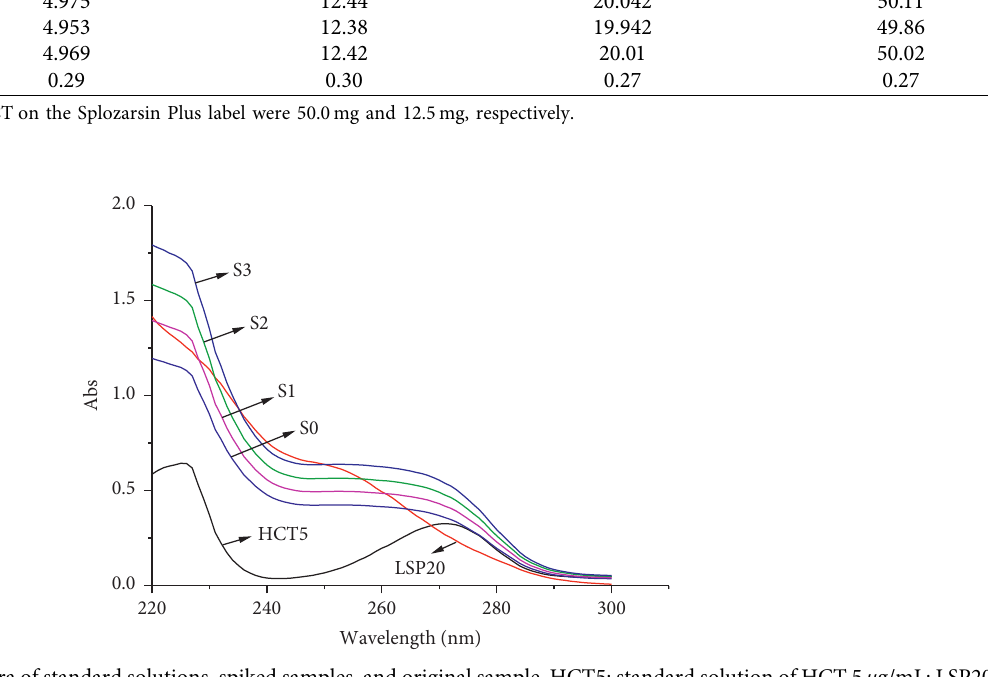
Figure 3: Absorption spectra of standard solutions, spiked samples, and original sample. HCT5: standard solution of HCT 5 μ g/mL; LSP20: standard solution of LSP 20 μ g/mL; S0: original samples; S1: spiked sample level 1 (HCTad � 0.500 μ g/mL, LSPad � 2.000 μ g/mL); S2: spiked sample level 2 (HCTad � 1.000 μ g/mL, LSPad � 4.000 μ g/mL); S3: spiked sample level 3 (HCTad � 1.500 μ g/mL, LSPad � 6.000 μ